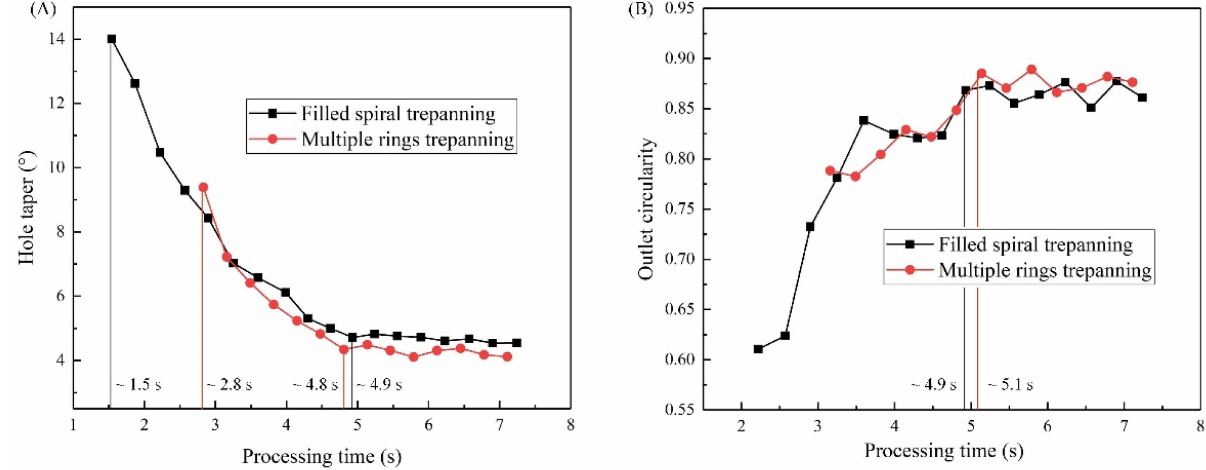
Figure 3. Hole taper and outlet circularity ablated with two trepanning patterns in Al 2 O 3 ceramic (0.38 mm thickness), ( A ) Processing time versus hole taper, ( B ) Processing time versus outlet circularity.